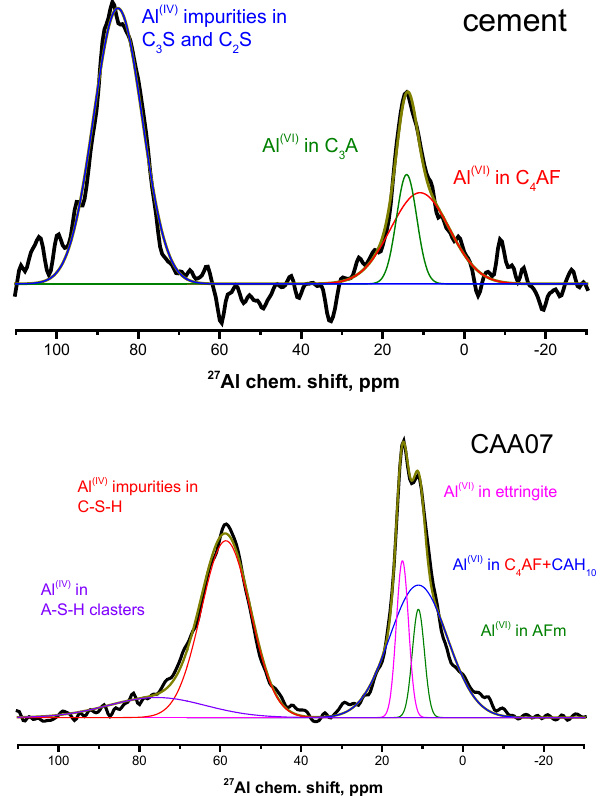
Figure 2. 27 Al NMR spectra of the ( top ) anhydrated Portland-limestone cement, and ( bottom ) cement paste sample with acetic acid addition at the 7th day of hydration.